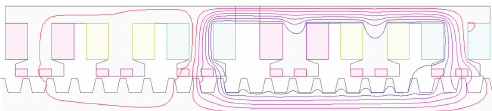
Figure 13: Magnetic field distributions only excited by armature current.